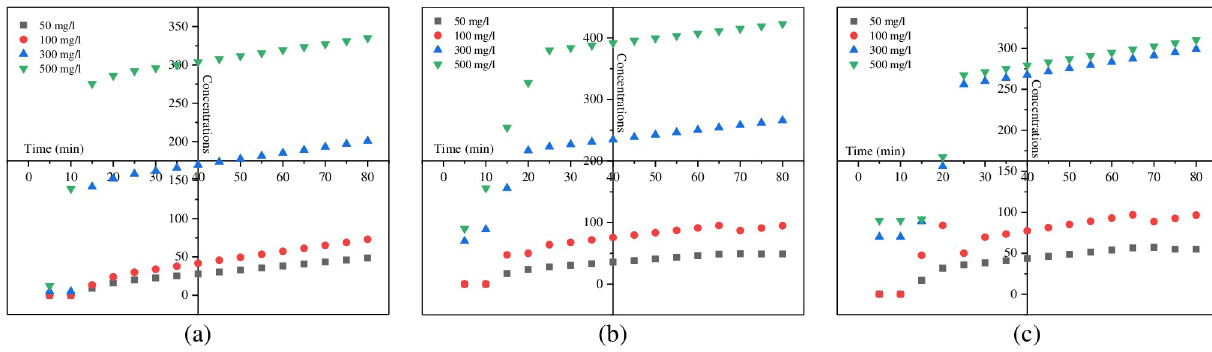
Fig 11. Influence of contact time on adsorption of (a) Zn +2 , (b) Pb +2 , and (c) Cd +2 in SnCaAl 2 O 3 NPs at constant adsorbent dose, initial concentration of ions, and volume of polluted water.